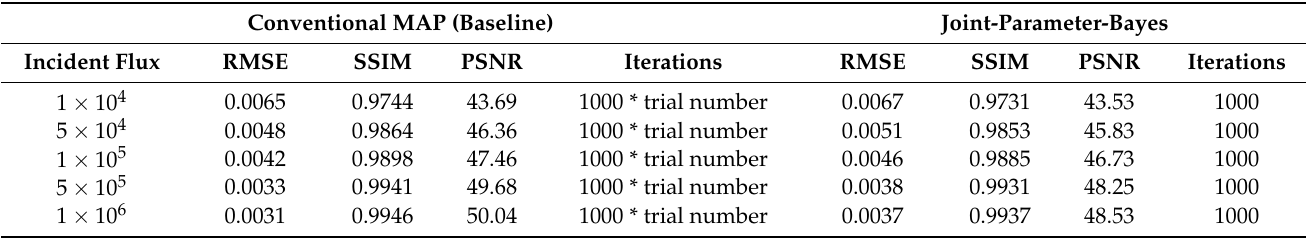
Table A2. Quantitative comparison of joint-parameter-Bayes with conventional MAP (baseline) with Poisson noise to pre-log transmission